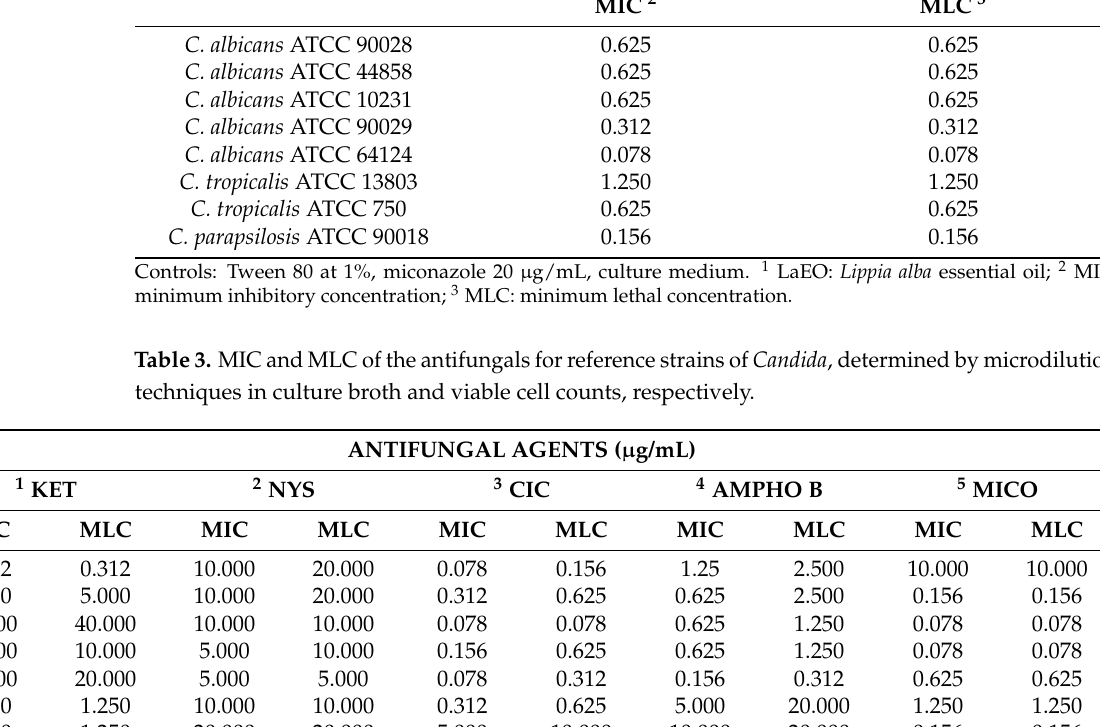
Table 2. MIC and MLC of LaEO for Candida strains, determined by microdilution techniques in culture broth and viable cell counts, respectively. Strains 1 LaEO (mg/mL)